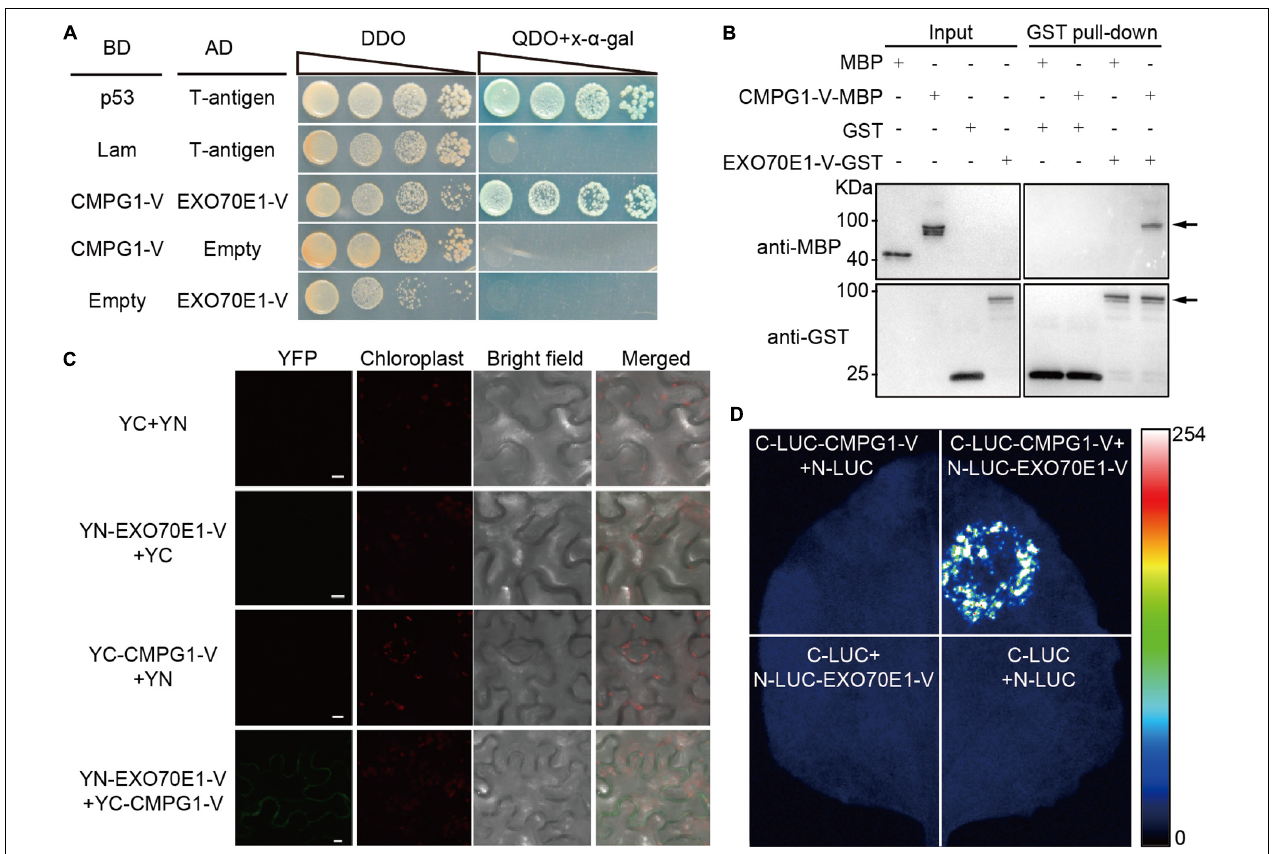
FIGURE 1 | Interaction analysis between EXO70E1-V and CMPG1-V. (A) Analysis of EXO70E1-V and CMPG1-V interaction on double dropout or quadruple dropout medium by yeast two-hybrid (Y2H). Interaction of CMPG1-V (fused to BD, pGBKT7) with EXO70E1-V (fused to AD, pGADT7) by a Y2H experiment. p53 (pGBKT7-53)/T-antigen (pGADT7-T) and Lam (pGBKT7-Lam)/T-antigen were positive and negative controls, respectively. (B) In vitro EXO70E1-V/CMPG1-V interaction analysis using the GST pull-down assay. Anti-MBP antibody was used to detect the GST pull-down products, and the CMPG1-V-MBP could be detected only when co-incubated with EXO70E1-V-GST. Arrowheads indicate the CMPG1-V-MBP (upper panel) and the EXO70E1-V-GST (lower panel) proteins, respectively. (C) In vivo EXO70E1-V/CMPG1-V interaction analysis by BiFC assay in the Nicotiana benthamiana epidermal cells. The green channel shows the localization of the yellow fluorescent protein (YFP) and its fusion proteins, and the red channel shows the location of the chloroplast. YN and YC indicate N-terminal and C-terminal of YFP, respectively. Scale bar = 10 µ m. (D) In vivo EXO70E1-V/CMPG1-V interaction analysis by LUI assay in the N. benthamiana epidermal cells. LUI image of N. benthamiana leaves co-infiltrated with the agrobacterial strains containing N-LUC-EXO70E1-V and